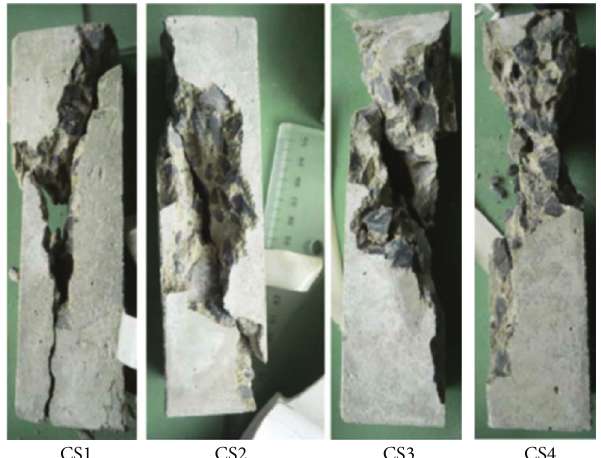
Figure 5: Photos of failed samples in brittle creep experiments.